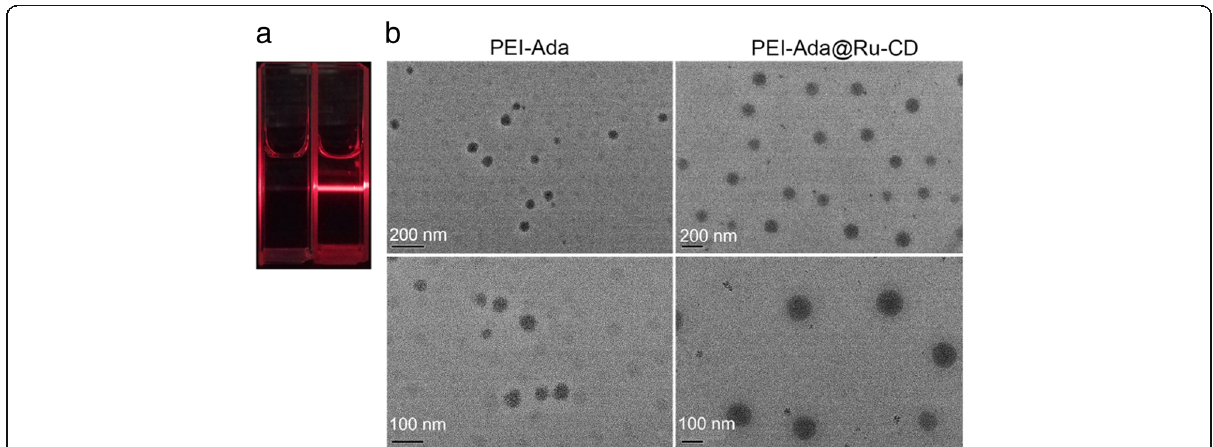
Fig. 2 a Images of the Tyndall effect of PEI-Ada (left) and the Ru-CD aggregate solution after adding PEI-Ada (right). b TEM images of PEI-Ada and PEI-Ada@Ru-CD